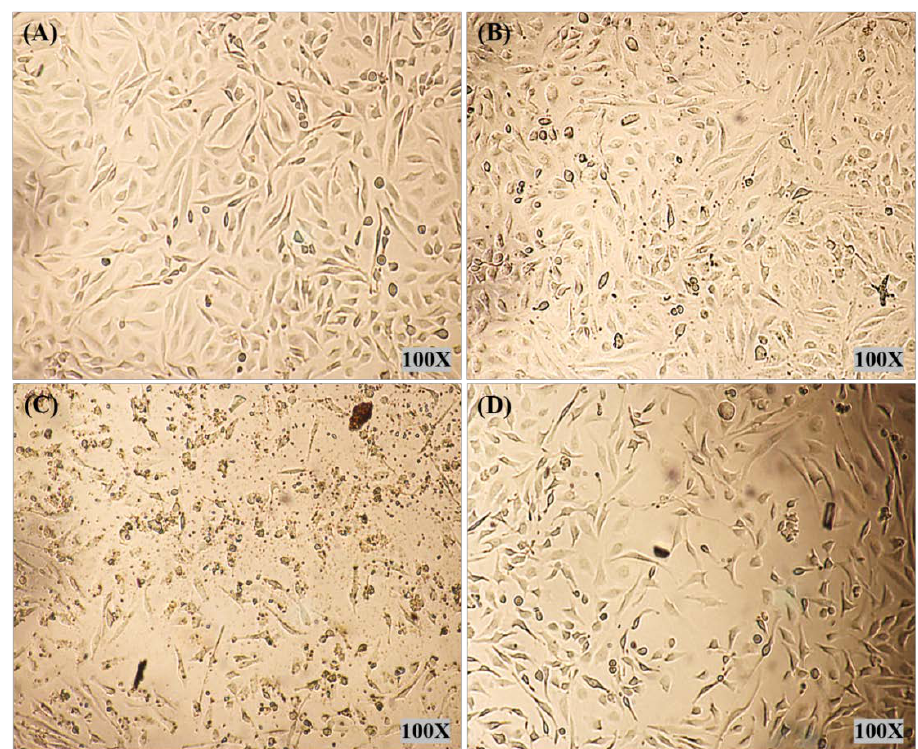
Figure 7. Cell morphology images of HELA cells after 24 h of treatment. HELA cells were treated at a concentration of 71.83 µg/mL with ( A ) control (no treatment), ( B ) PMMA-NR, ( C ) PMMA-NR-Si-TAM and ( D ) free TAM. The small black dots are the nanoparticles and the brown debris is the dead cells.